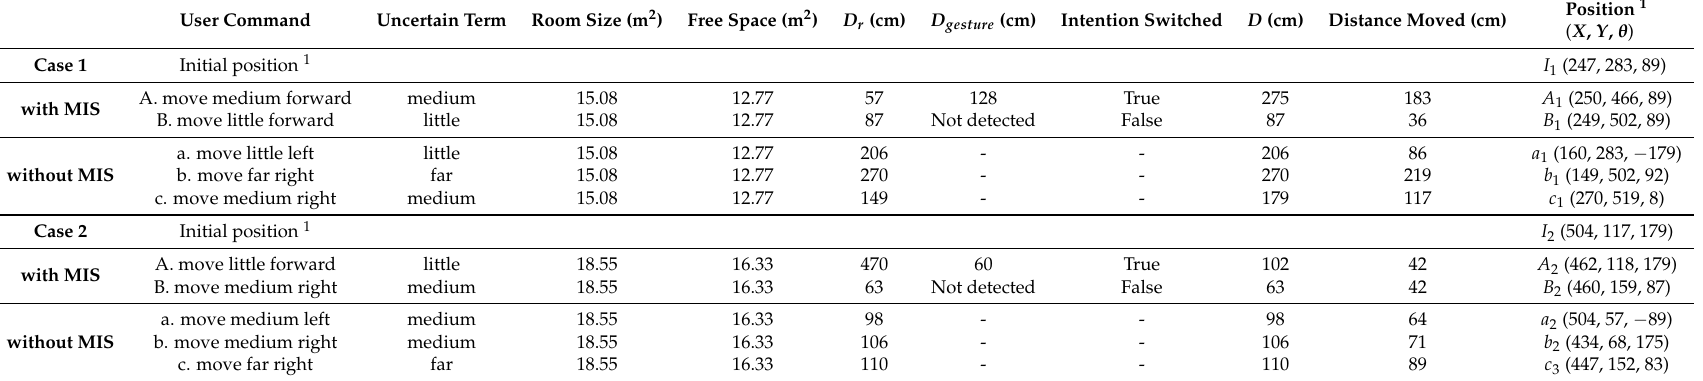
Table 3. Sample results of the experiment for evaluating the performance gain of the system with the motion intention switcher